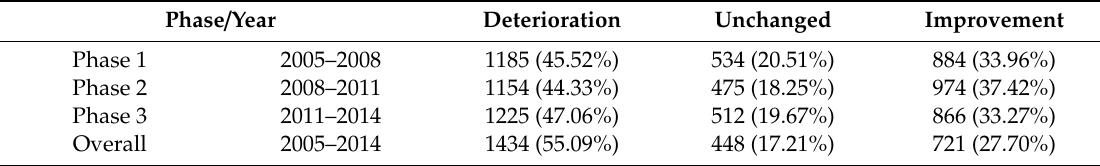
Table 3. Changes in cognitive function of the Chinese elderly: 2005–2014. Phase / Year Deterioration